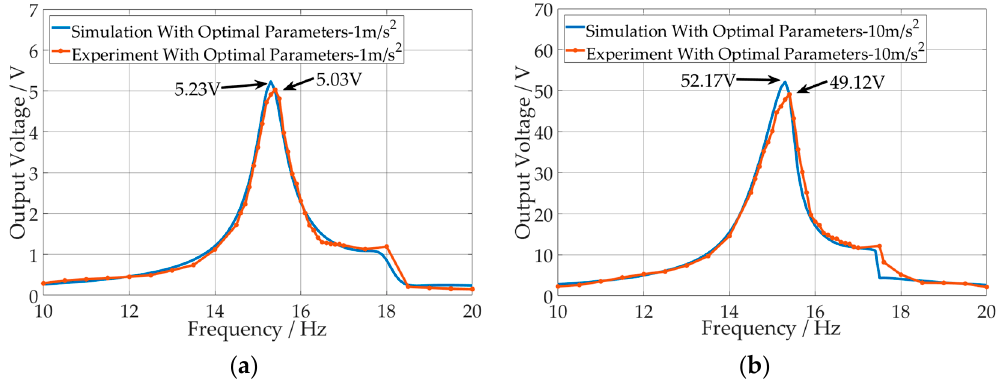
Figure 13. Optimal output voltage: ( a ) 1 m/s 2 ; ( b ) 10 m/s 2 .